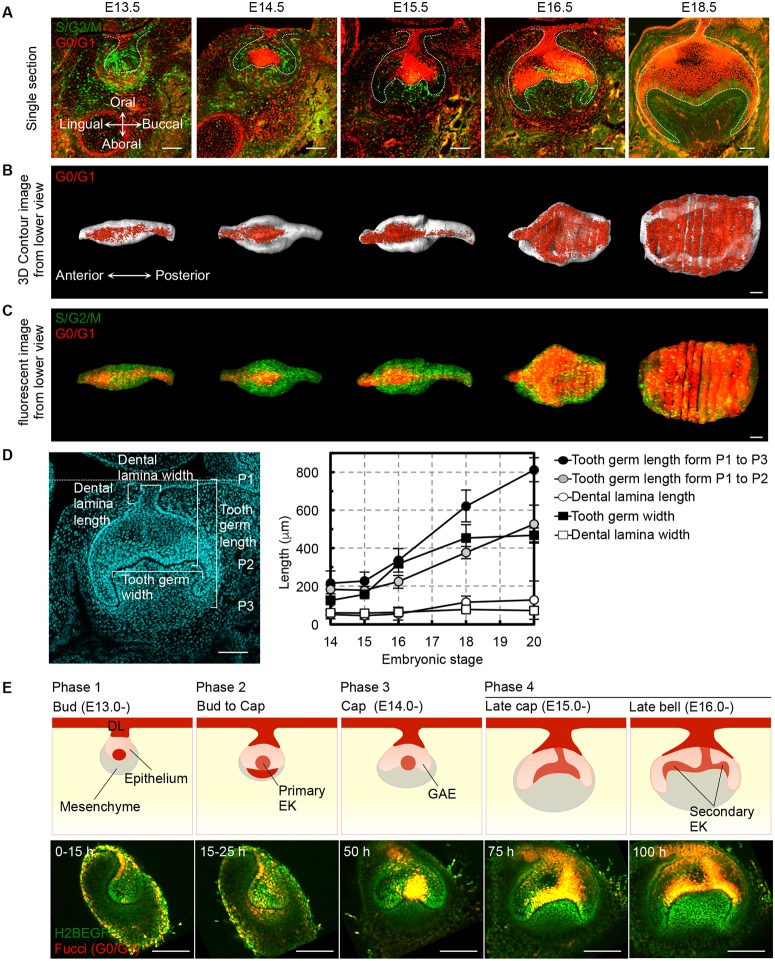
Tooth morphogenesis and spatial-temporal cell proliferation.(A) Frontal sections of mandibular molar tooth germ derived from Fucci mice at embryonic day (E) 13.5–18.5. The lingual side is on the left in all panels. The scale bars represent 100 μm. (B) Three-dimensional volume rendering images of the molar epithelium shown from the jaw side. The scale bars represent 100 μm. (C) Three-dimensional reconstructions of frontal sections of Fucci tooth germ epithelia showing the cell proliferation pattern. The scale bars represent 100 μm. (D) Length and width measurements of each part of the molar tooth germ. The results are provided as the mean ± s.d. of 6 samples (E14), 6 samples (E15), 8 samples (E16), 7 samples (E18) and 4 samples (E20). The measurement parts are indicated in the left figure. The scale bars represent 100 μm. (E)
Ex vivo imaging of four phases during tooth germ epithelium morphogenesis. Schematic (upper panels) and captured live images (lower panels) are provided. The lingual side is on the left in all panels. Red indicates the growth-arrested regions. DL, dental lamina; EK, enamel knot; GAE, growing apex of epithelium. The scale bars represent 100 μm.